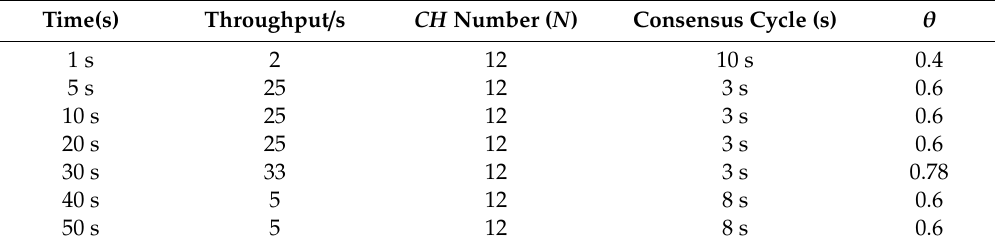
Table 2. Experimental parameters of dynamic high throughput management (DHM) efficiency.